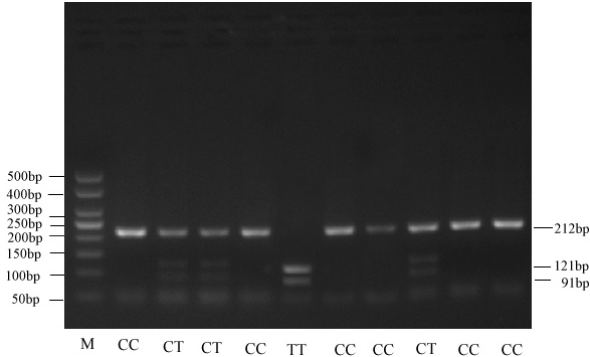
Figure 1. PCR-RFLP band pattern on a 3% agarose gel. The TT genotype has two bands (121 and 91bp) which run fast; the CC genotype has one band (212bp) which runs slowly; the CT genotype has three bands (212, 121 and 91bp), with one running slowly and the others running